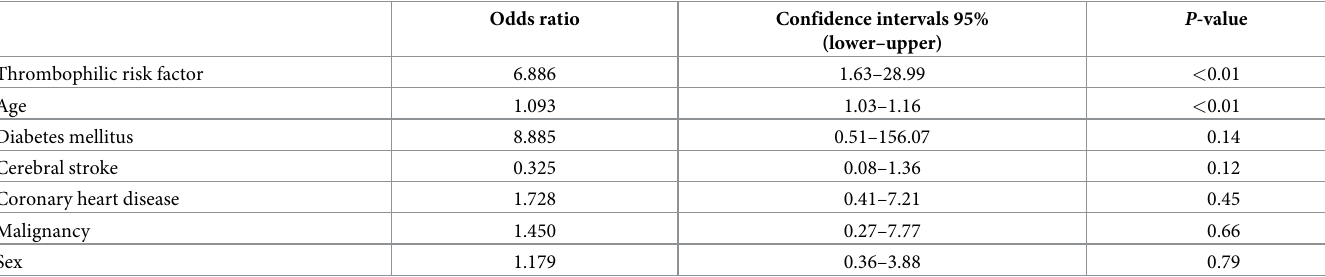
Table 3. Risk for early shunt